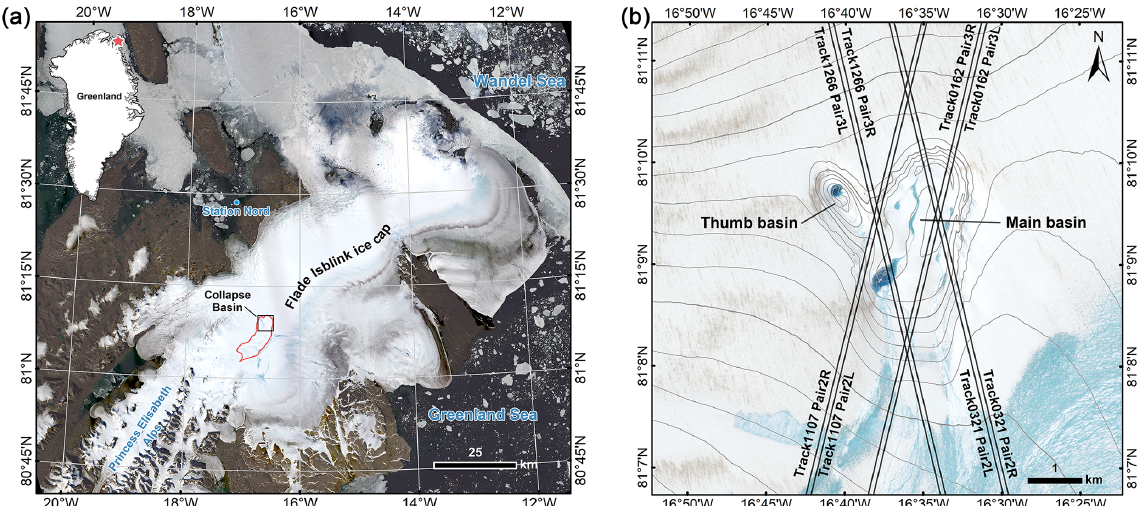
Figure 1. Map of the study area. (a) Flade Isblink ice cap. Background is a Landsat 8 OLI image acquired on 13 August 2015. The black box shows the location of (b) . The red line is the catchment boundary. (b) Sentinel-2 MSI image of the deep basin acquired on 5 August 2020. The grey 10m contours are derived from ArcticDEM strip data from 20 April 2015. Black lines indicate the four pairs of ICESat-2 single-beam tracks that pass through the collapse basin. The supraglacial meltwater formed in summer usually flows northward and drains into the ice sheet through crevasses and